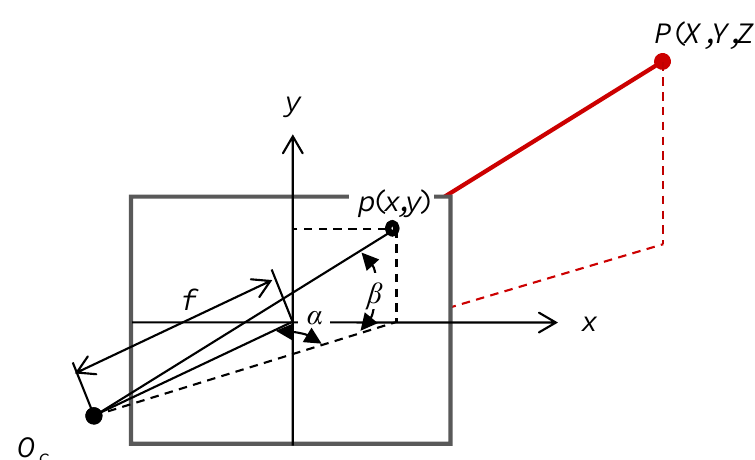
Figure 7. Angles of the